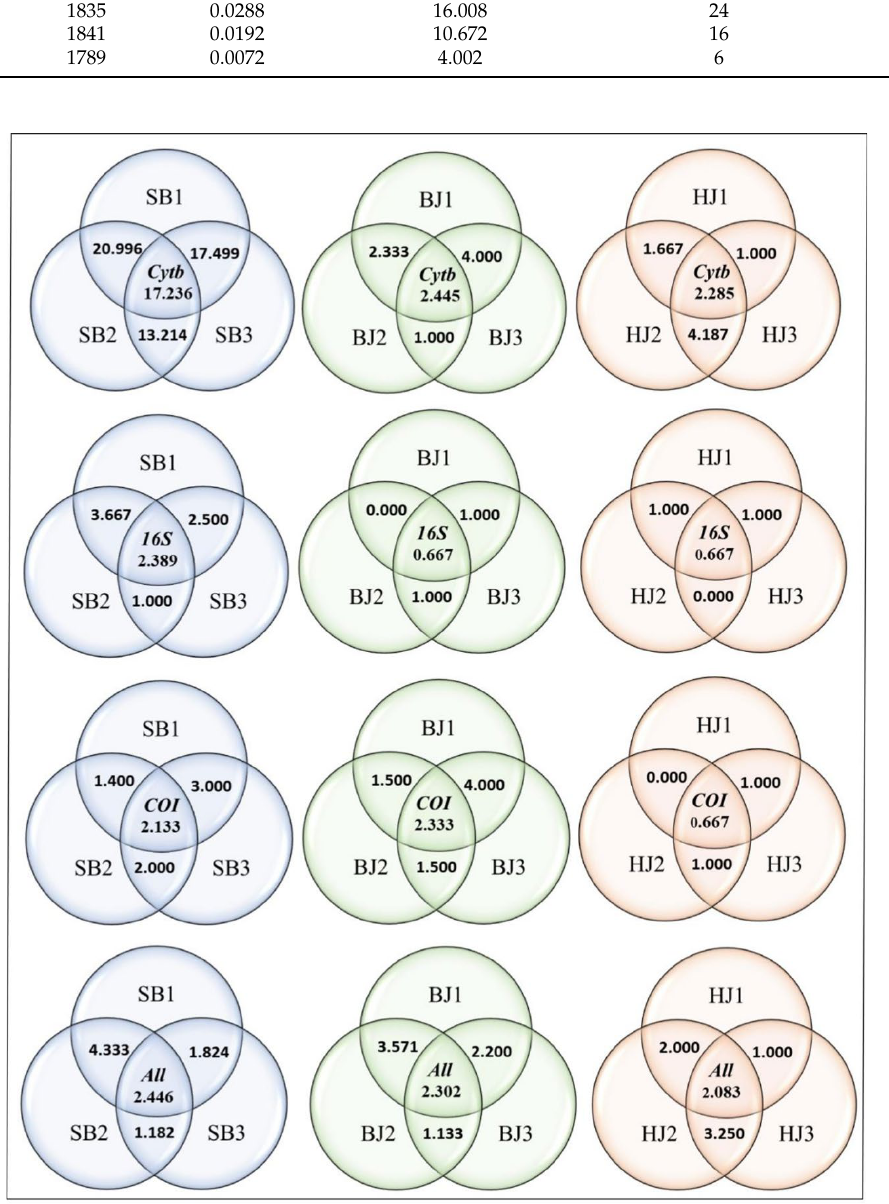
Figure 8. Gene-flow ( N m ) of fragmented populations of Erythroneurine leafhoppers in the study areas.